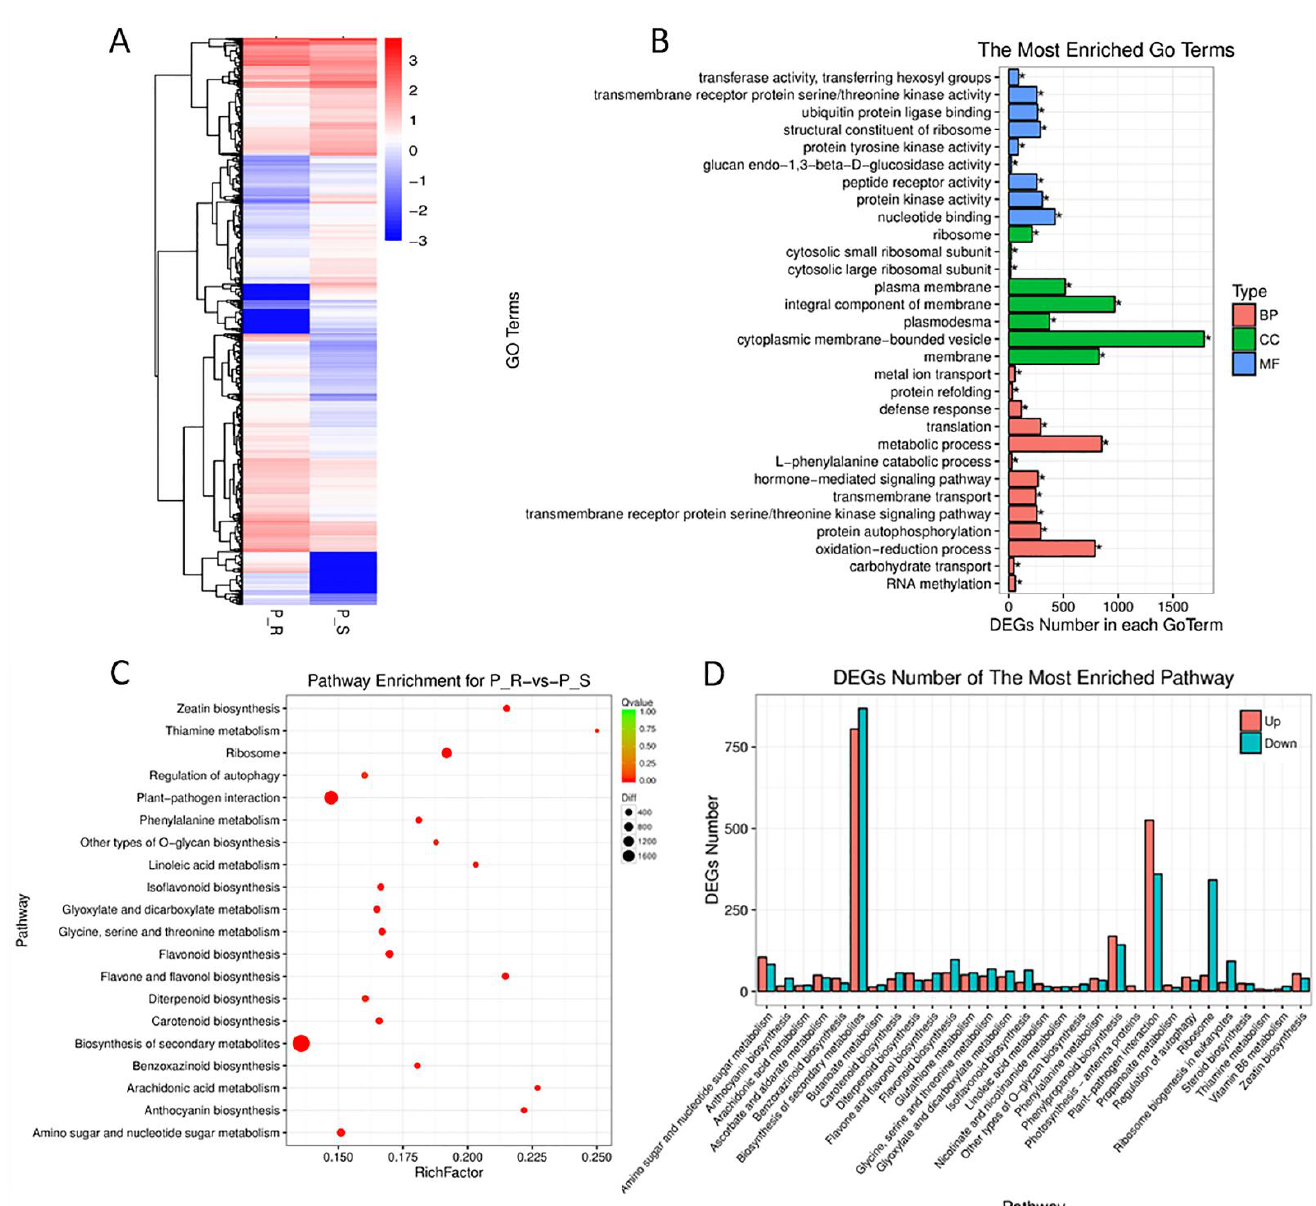
Figure 5. Gene ontology (GO) analysis of the differentially expressed genes (DEGs) between Tutoumai (TTM) and Siyang 936 (SY936). ( A ) Cluster heat map of DEGs between the resistant parent TTM (P_R) and susceptible parent SY936 (R_S). ( B ) The most enriched GO terms of the DEGs. ( C ) Pathway enrichment of the DEGs. ( D ) Number of DEGs of the most enriched pathway.